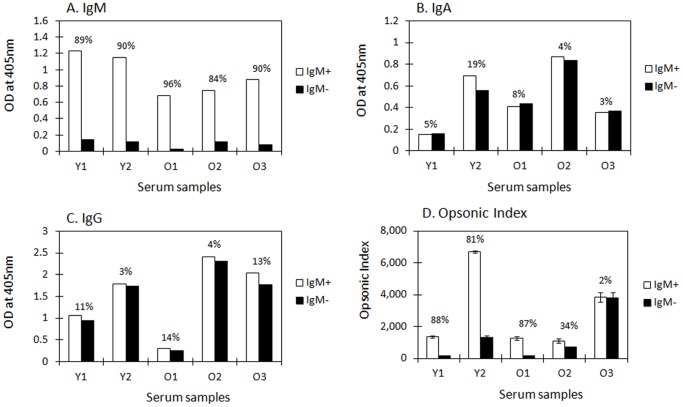
Absorption of IgM from sera immunized with PPV23.Five representative serum samples (Y1, Y2, O1, O2 and O3) were randomly selected from young (Y) or old adults (O) immunized with PPV23. The levels of IgA and IgM were measured at 80-fold dilution and the level of IgG was measured at 400-fold dilution. IgM+ and IgM- indicate mock-absorption and IgM-absorption, respectively. The levels of serotype 23F specific IgM (A), IgA (B), and IgG (C) are shown for mock- or IgM-absorption from immune sera. We chose 80-fold dilution for IgA and IgM, and 400-fold dilution for IgG based on a serial dilution curve ELISA. The numbers (%) indicate the percent change in OD at 405 nm (A, B, C) or OI after IgM absorption. D, Opsonic index (OI) of five immune sera is shown after mock- or IgM-absorption. Data shown in Figure 3D are the mean ± standard error (SE) of two independent experiments.